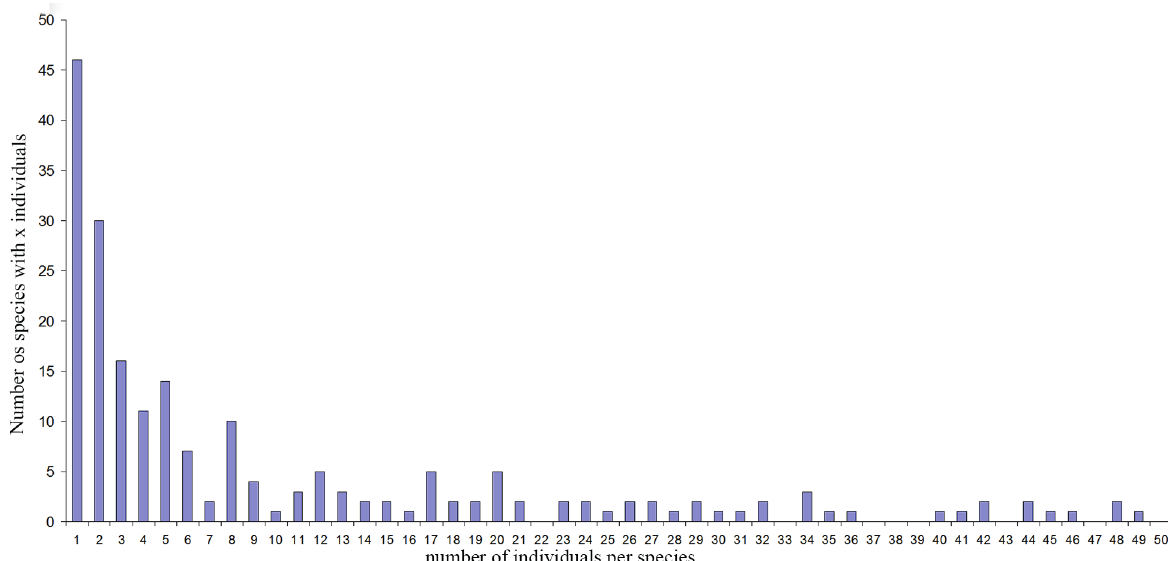
Figure 1 - Frequency of occurrence of specimens of species mapped in monographs (Hopkins